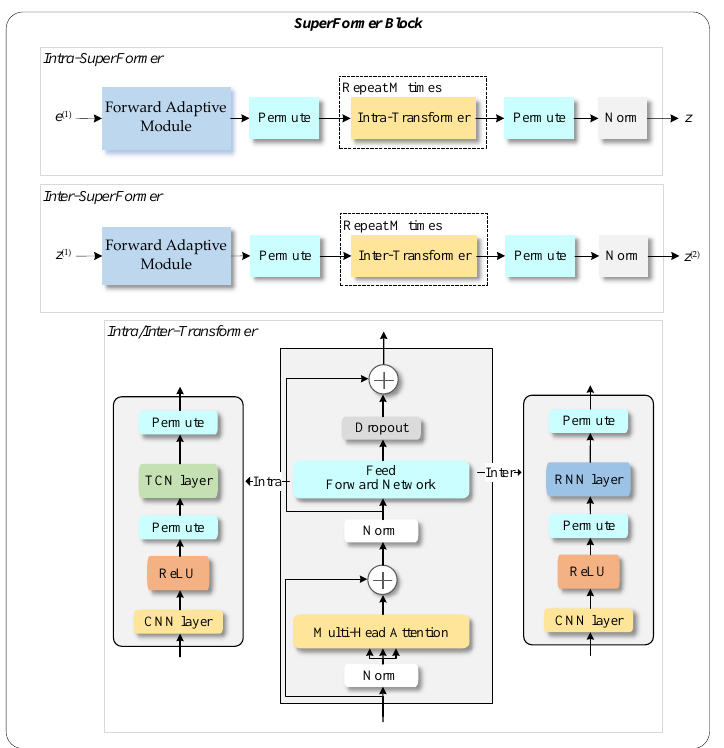
Figure 2. Structure design of the SuperFormer Block, including the Intra-SuperFormer and Inter- SuperFormer with different structures. The difference between the two modules lies in the structure of FFN module in transformer. The Intra-Transformer uses a TCN layer to learn the intra -block data correlation of speech, and the Inter-Transformer uses an RNN network to learn the inter -block data correlation of speech.